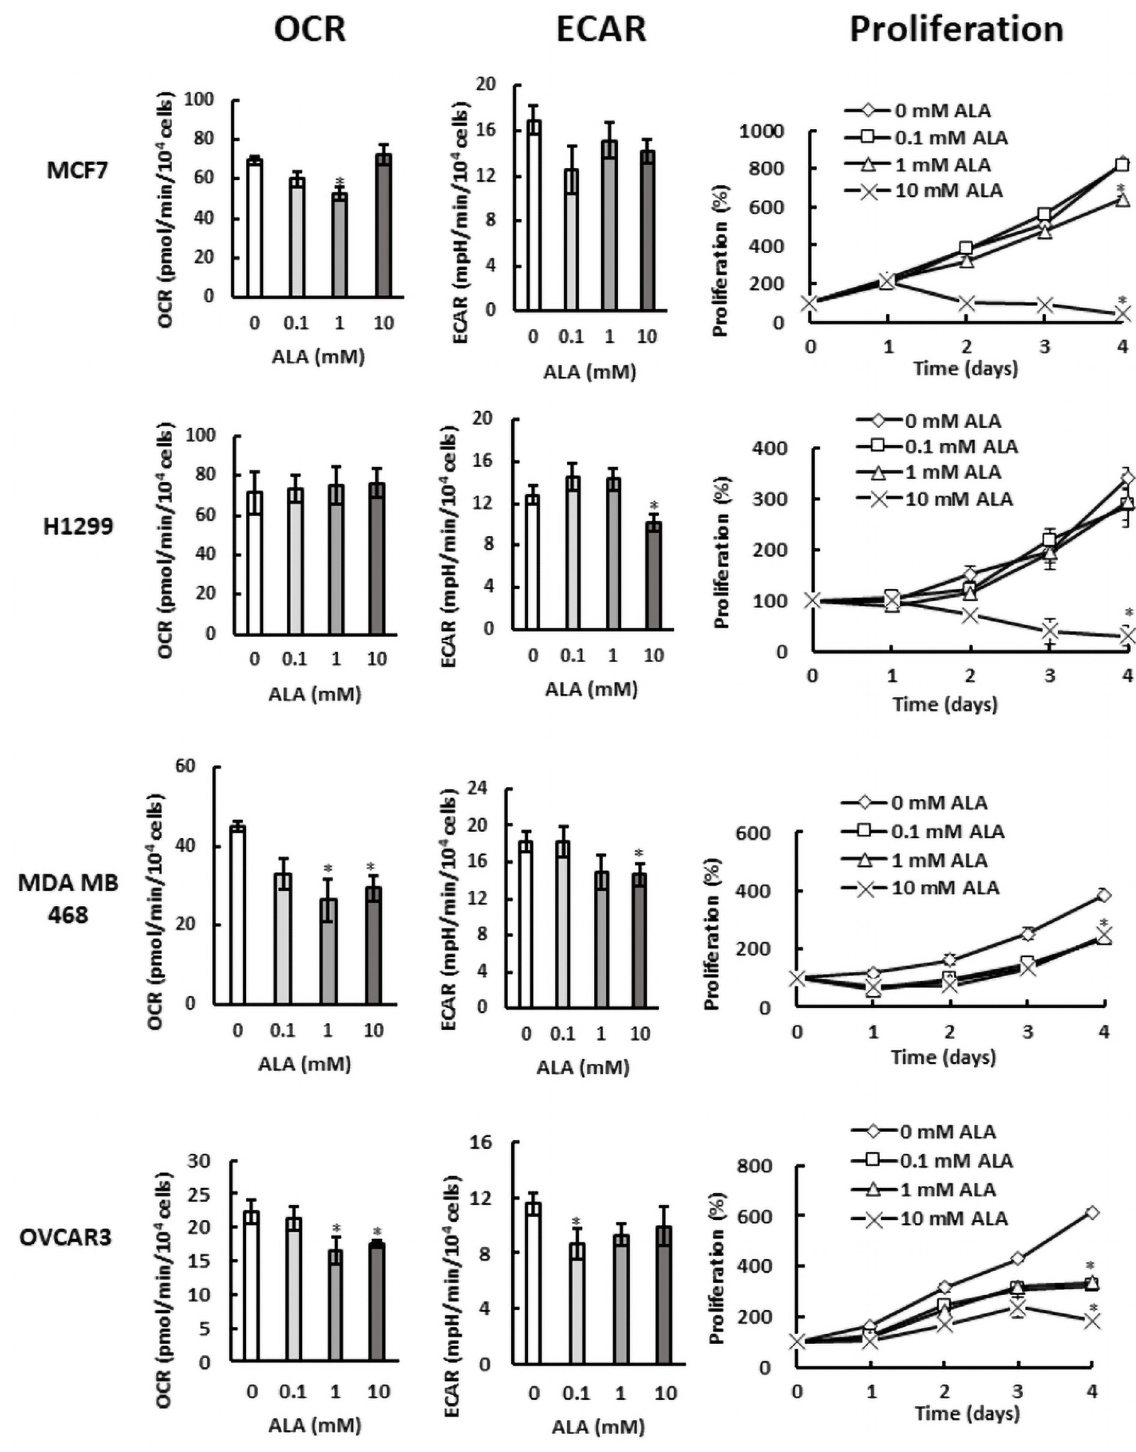
Fig 8. Cells with different activities of aerobic metabolism display unique patterns of ALA sensitivity. OCR, ECAR, and proliferation in breast cancer MCF7 cells, lung cancer H1299 cells, TNBC cells MDA MB 468, and ovarian cancer OVCAR3 cells.